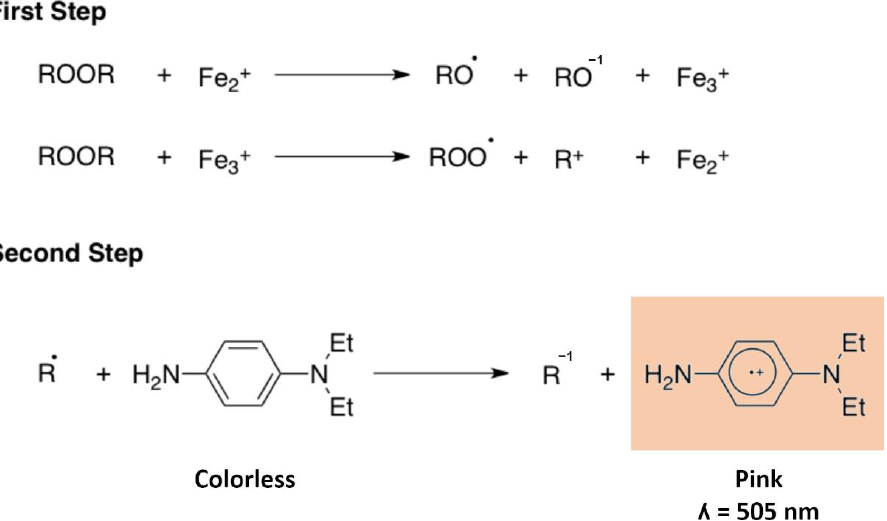
Figure 6. Schematic representation of the sequential reactions occurring in the d-ROMs